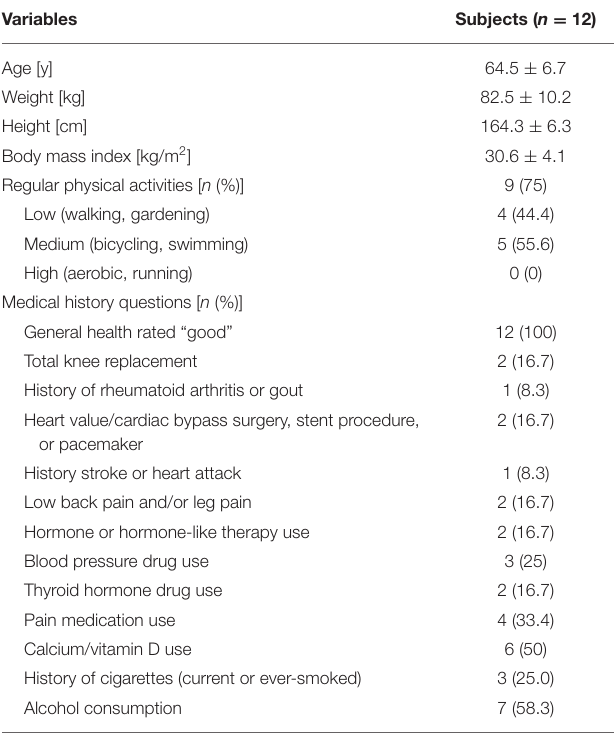
TABLE 1 | Demographic characteristics of study